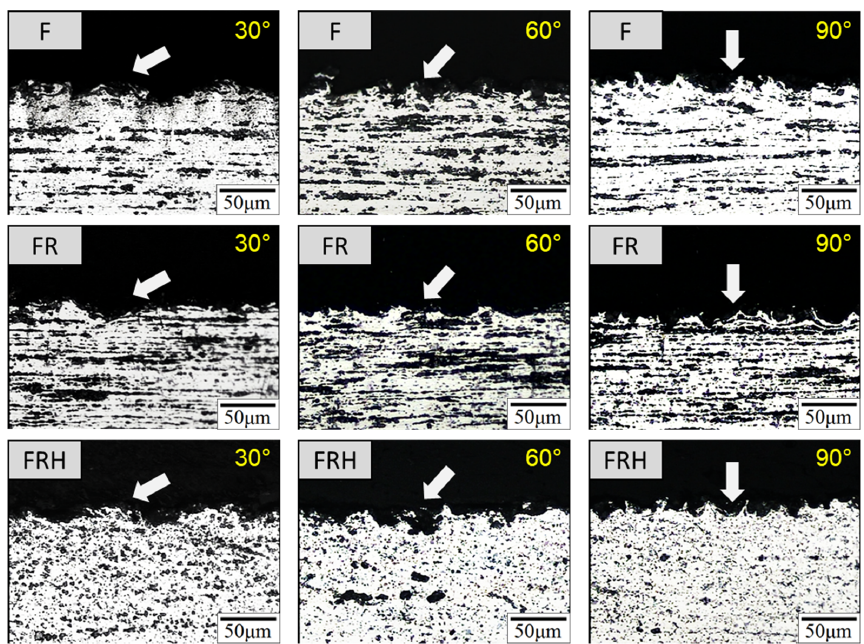
Figure 8. Microstructure characteristics of the subsurface of erosion (the arrow represents the direction of particle erosion).